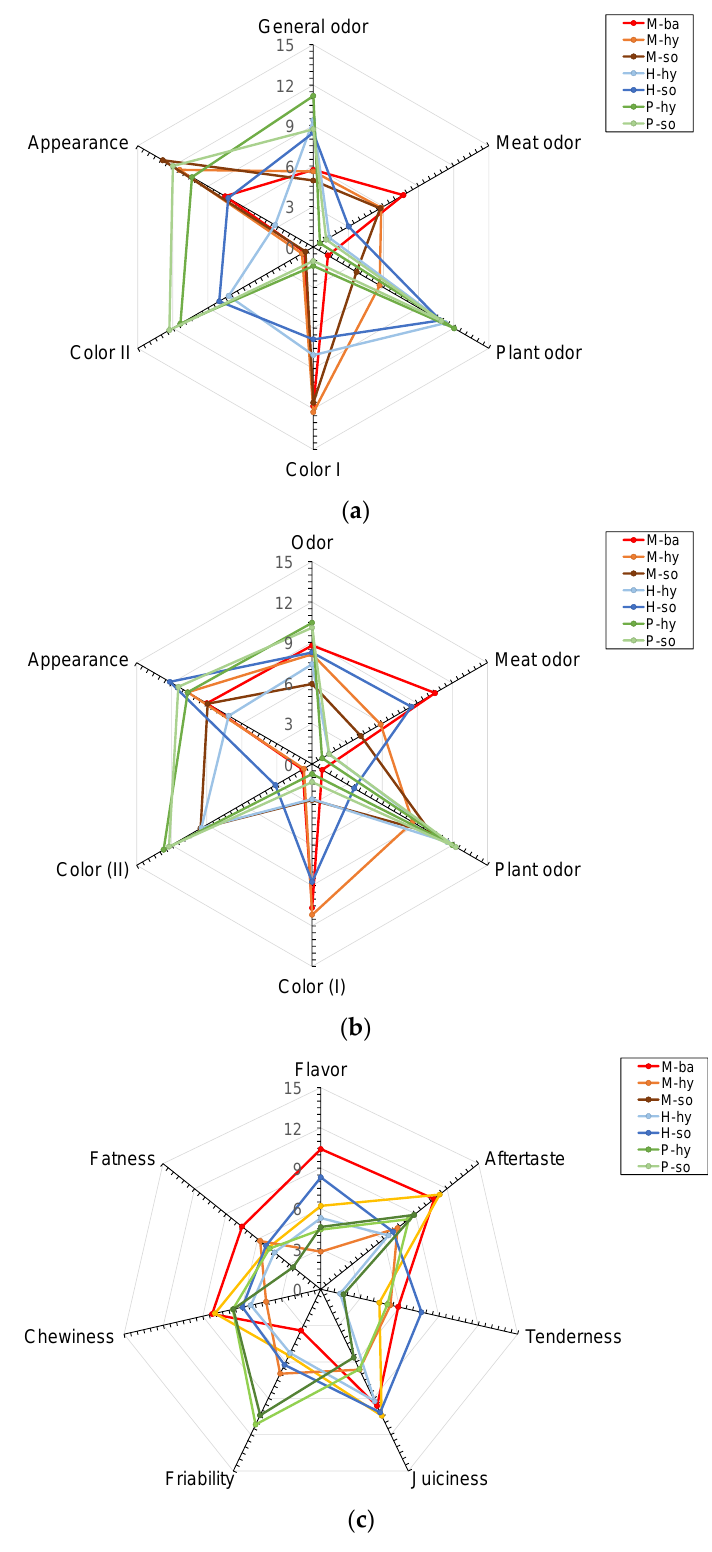
Figure 3. Sensory profile of samples treated by HPP ( a ) or HPP + SVCOOK ( b , c ), according to protein matrix (M = meat-based patty; H = hybrid patty; P = plant-based patty) and fat replacement ( ba : backfat; hy : hydrocolloid emulsion; so : soya emulsion.